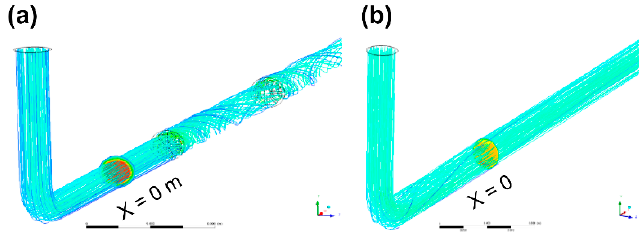
Figure 6. Streamlines originating from the pipe inlet ( a )with turbulent insert, ( b )baseline